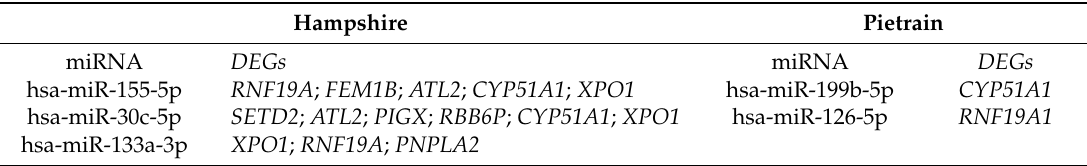
Table 4. The miRNA-mRNA interactions identified between differentially expressed miRNAs and genes based on the DIANA-miRextra v2.0 tool (DIANA-Lab, Athens, Greece). Hampshire Pietrain miRNA DEGs miRNA DEGs hsa-miR-155-5p RNF19A ; FEM1B ; ATL2 ; CYP51A1 ; XPO1 hsa-miR-199b-5p CYP51A1 hsa-miR-30c-5p SETD2 ; ATL2 ; PIGX ; RBB6P ; CYP51A1 ; XPO1 hsa-miR-126-5p RNF19A1